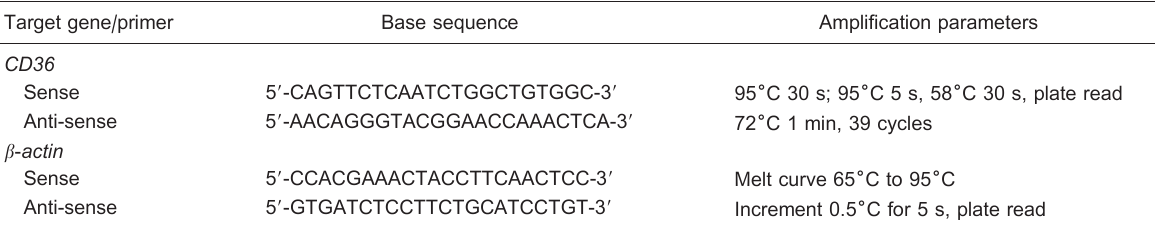
Table 2. Primers and amplification parameters of real time polymerase chain